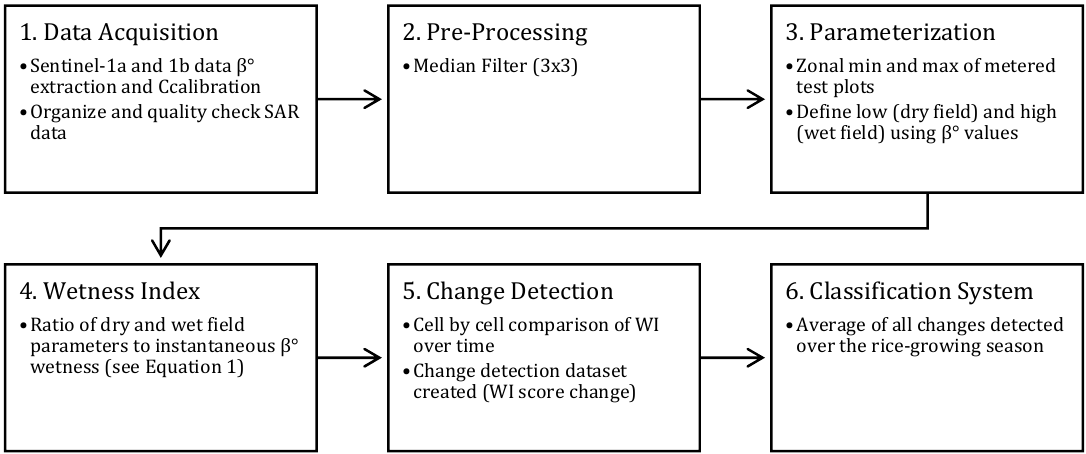
Figure 1. Remote sensing workflow. The workflow was adapted and developed throughout the project, based on previous WI studies, as well as project iterations.